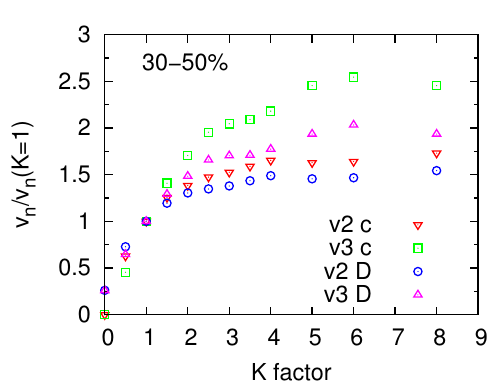
Figure 3. Same as Fig. 1 but for the collisional + radiative energy loss mechanism with K = 0 . 8.